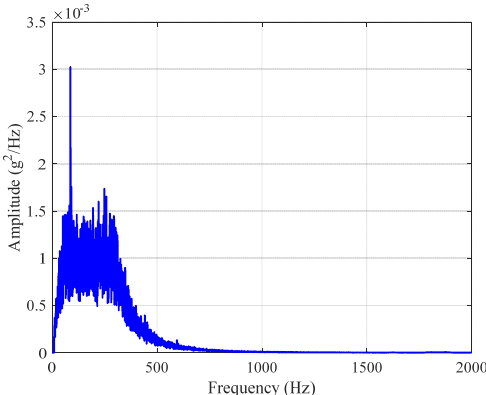
Figure 14. Random vibration load spectrum of experiment rack simulator.